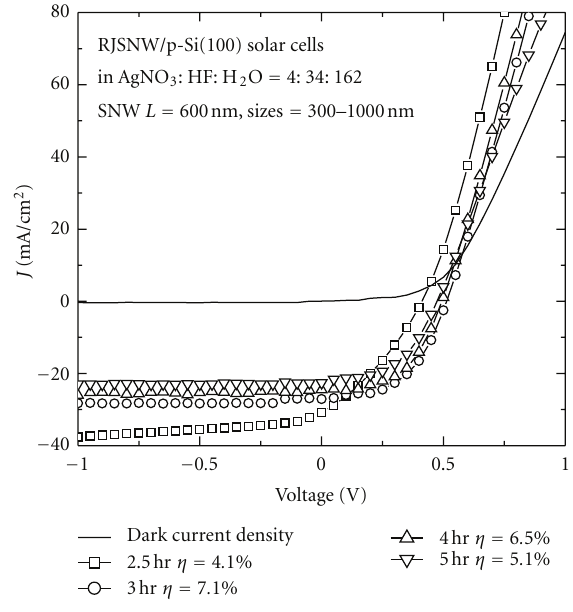
Figure 6: Reflectance spectra of various SNW/p-Si(100) structures with SNW lengths of 600, 900, and 10000 nm. Etching conditions were aqueous AgNO 3 /HF/H 2 O mixture chemical solution in a ratio of 4:34 :162 (volume) at 25 ◦ C for (a) 1.5, (b) 3, and (c) 30min. Reflectance spectrum of p-type planar Si(100) wafer is shown as reference. An integrating sphere was used to ensure that all reflected light was captured over all angles. The diameter of integrating sphere is 60mm.